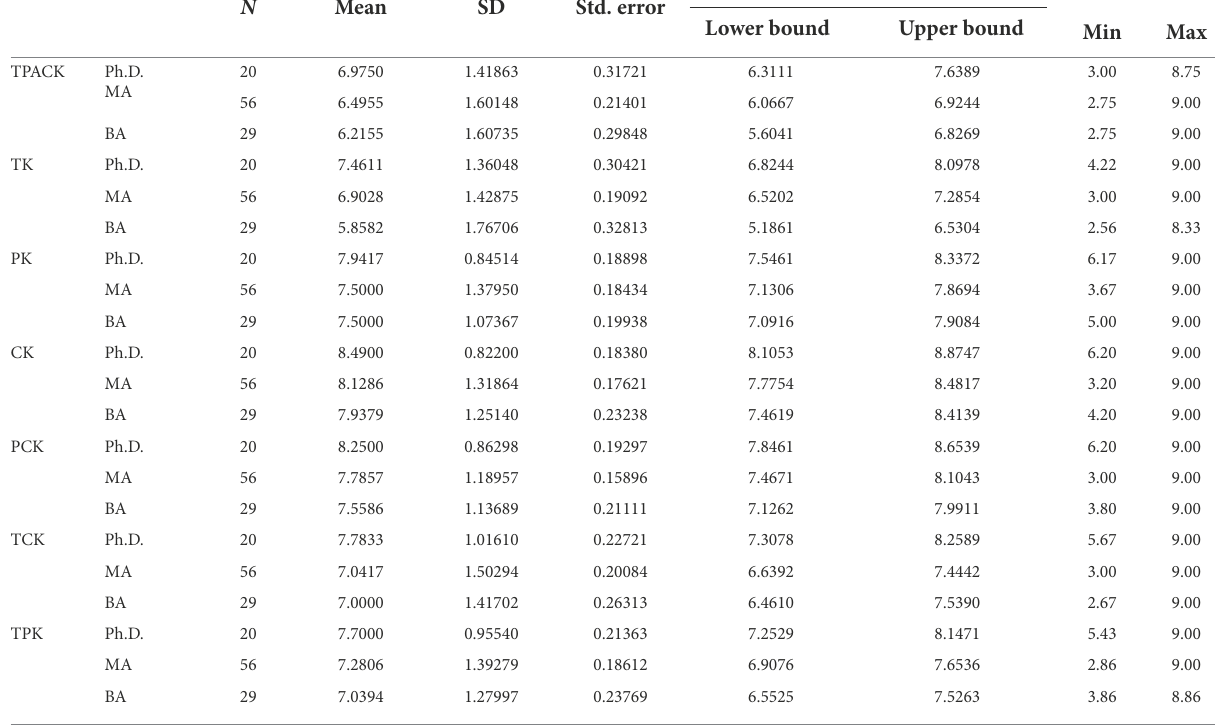
TABLE 5 Descriptive statistics for BA,MA, and PhD participant’s